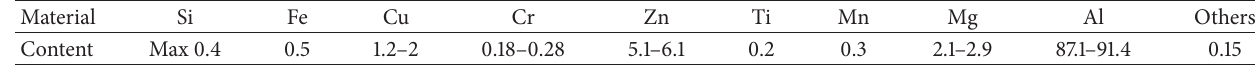
Table 1: Chemical composition (weight %) of aluminum matrix alloy (Al